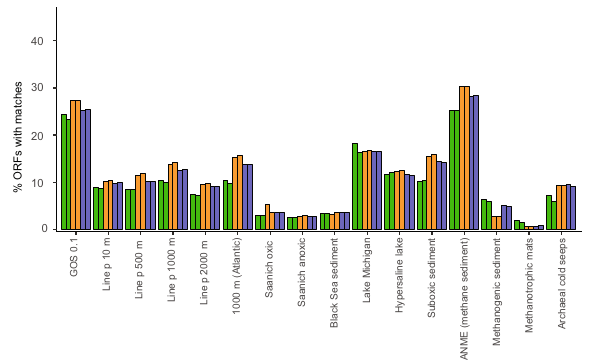
Fig. 2 Similarity of Äspö HRL ORFs to metagenomes from other environments. Percent of ORFs in the duplicate MM-171.3 (green),